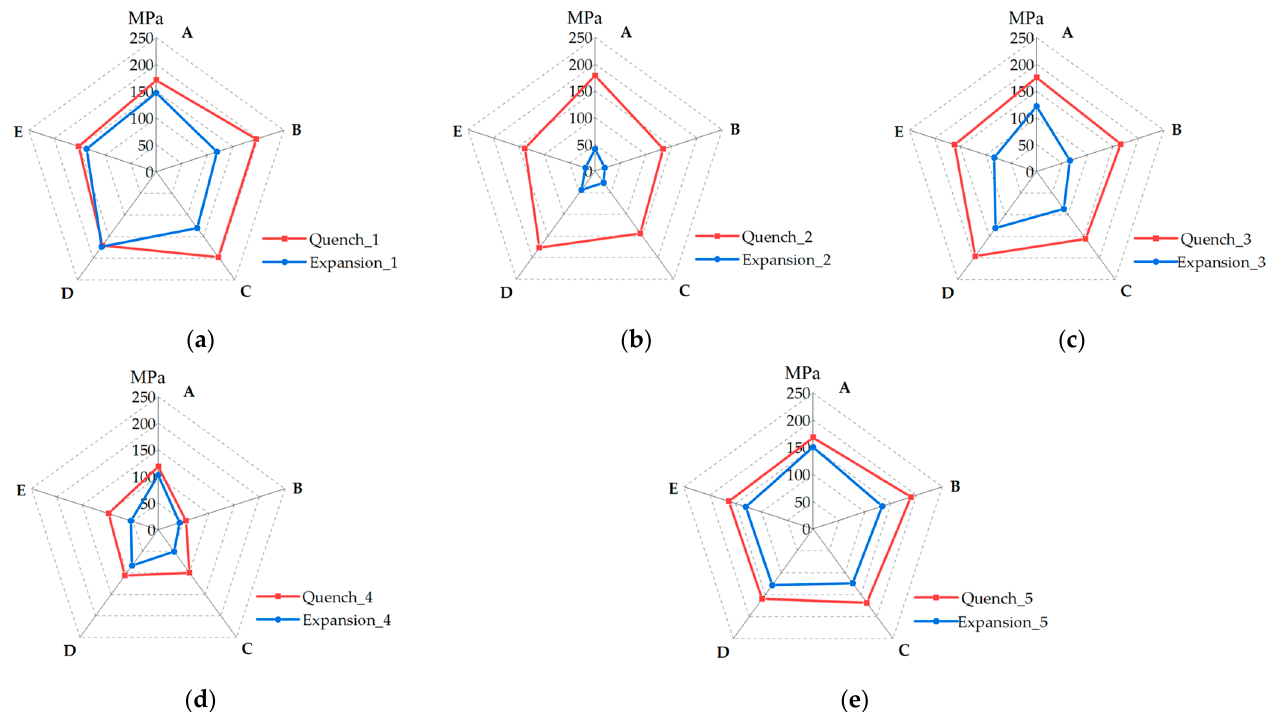
Figure 9. Von Mises stress after quenching and cold expansion of the central layer forging: ( a ) von Mises stress in region P1; ( b ) von Mises stress in region P2; ( c ) von Mises stress in region P3; ( d ) von Mises stress in region P4; ( e ) von Mises stress in region P5.